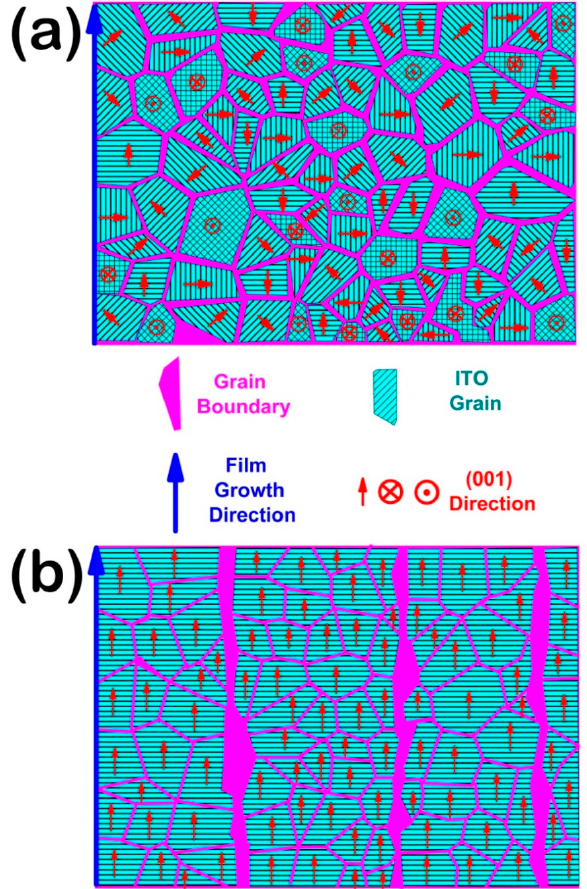
Figure 8. The cross-section diagrammatic sketch of the ITO film. ( a ) For polycrystalline without a preferred orientation; ( b ) for polycrystalline with a (100) preferred orientation.